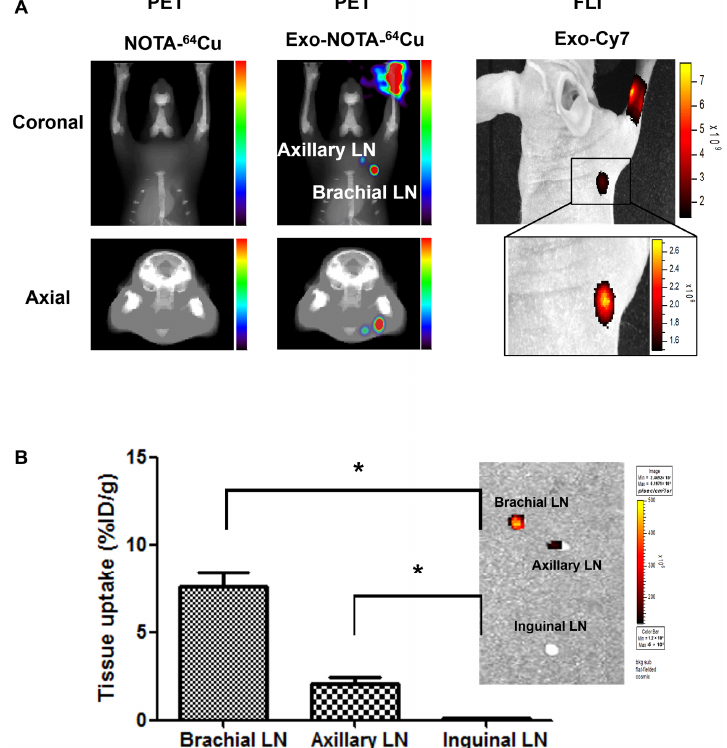
Figure 3. In vivo imaging of exosomes in the lymphatic route. ( A ) Footpad-injected exosomes (Exo-NOTA- 64 Cu) exhibited higher uptake in the lymph nodes than NOTA- 64 Cu. 64 Cu exosome signals are detected in the brachial and axillary lymph nodes with higher sensitivity than with fluorescence imaging; ( B ) Ex vivo fluorescence images show Cy7 signals of exosomes in the brachial and axillary lymph nodes. Radioactivity within brachial and axillary lymph nodes is stronger than that of the inguinal lymph nodes. Data represent mean ± SD ( n = 5/group). * means p < 0.05. 2.3. Ex Vivo Imaging of Radiolabeled/Fluorescently Labeled Exosomes in the Lymphatic Route Within surgically removed lymph nodes, Cy7 signals were high in the brachial and axillary nodes, similar to that observed in the PET images (Figure 3B). Radioactivity in the gamma counter was stronger in the brachial and axillary versus inguinal lymph nodes. Expression of the exosome marker CD63 was higher within exosome-injected mice as compared with untreated mice (Figure 4). In addition, CD63 expression was higher in the brachial and axillary lymph nodes as compared with the inguinal nodes. Confocal microscopy images confirmed that stronger Cy7 signals were present in the brachial and axillary lymph nodes as compared with the inguinal nodes.